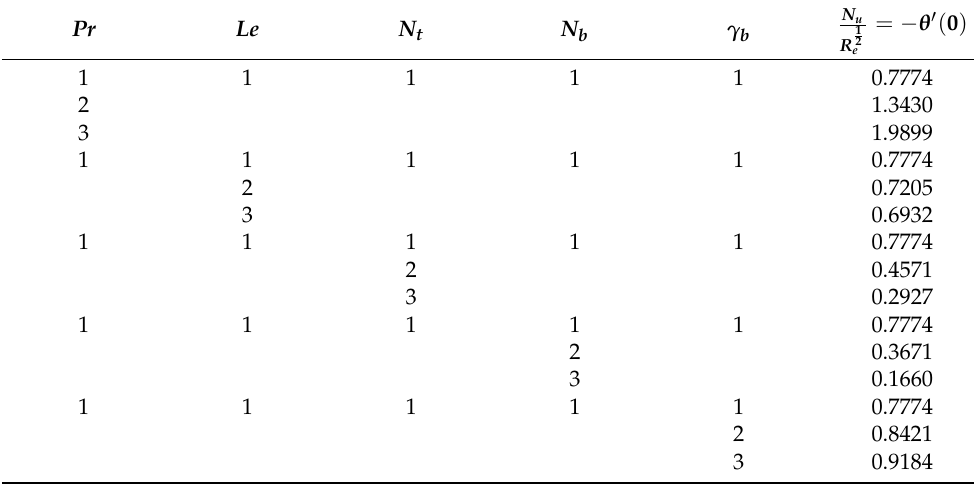
Figure 7. Influence of γ b over N u Table 1. The effect of different parameters on the Nusselt number.